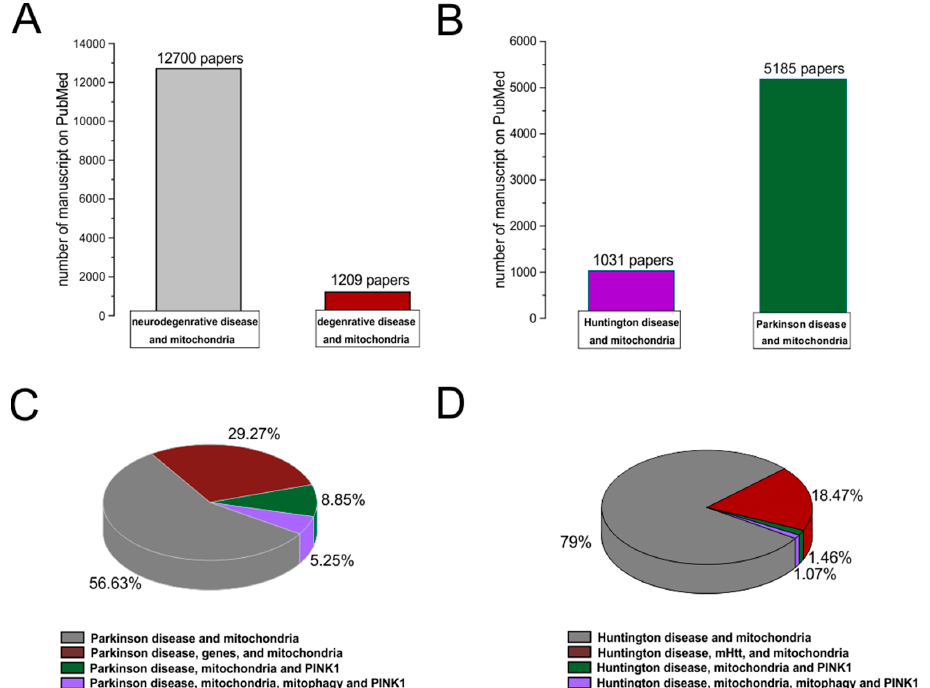
Figure 2. PubMed evidences of mitochondrial involvement in neuro-degenerative/degenerative dis- eases. Records were obtained from research articles published until January 2023. Article publications were obtained from the following PubMed searches: “Neurodegenerative disease and mitochon- dria; degenerative disease and mitochondria ( A ); HD and mitochondria; PD and mitochondria ( B )”. ( C , D ) To realize the pies on sub-items, we have selected “PD, genes, and mitochondria; PD, PINK1, and mitochondria; PD, PINK1, mitophagy, and mitochondria; HD, mHHT, and mitochondria; HD, mHHT, mitophagy, and